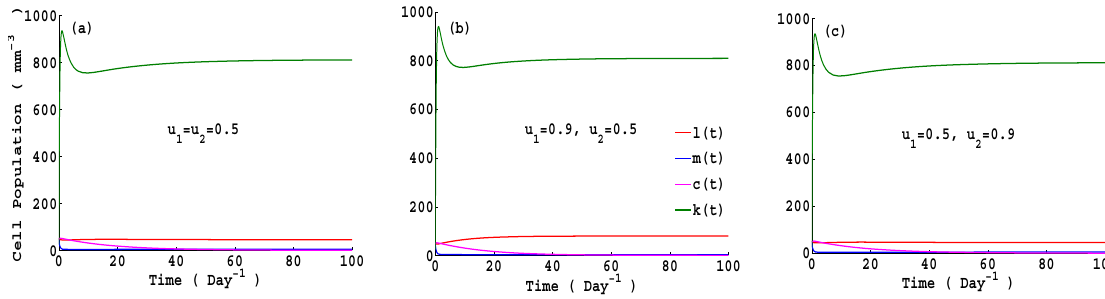
Fig. 2. Behaviors of different cell biological masses of the system (1) for different values of two drug efficacy parameters u 1 and u 2 , keeping other parameters at their standard values as in Table